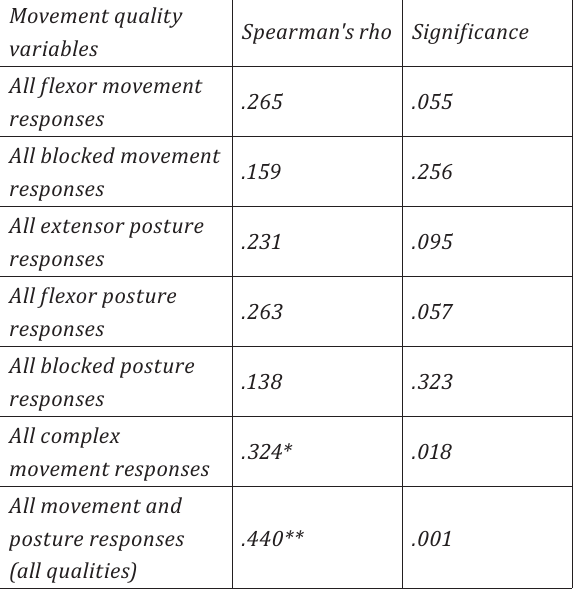
Table 13. The values of Spearman’s rho between the “chiaroscuro” variable and movement quality variables